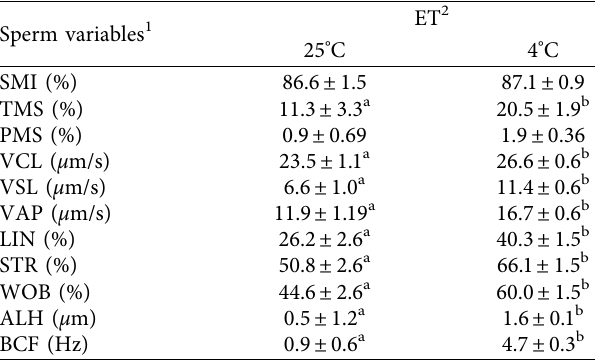
1 SMI: sperm membrane integrity; TMS: total motile sperm; PMS: pro- gressive motile sperm; VCL: curvilinear velocity; VSL: straight-line velocity; VAP: average path velocity; LIN � VSL/VCL × 100; STR � VSL/VAP × 100; WOB � VAP/VCL × 100; ALH: amplitude of lateral head displacement; BCF: